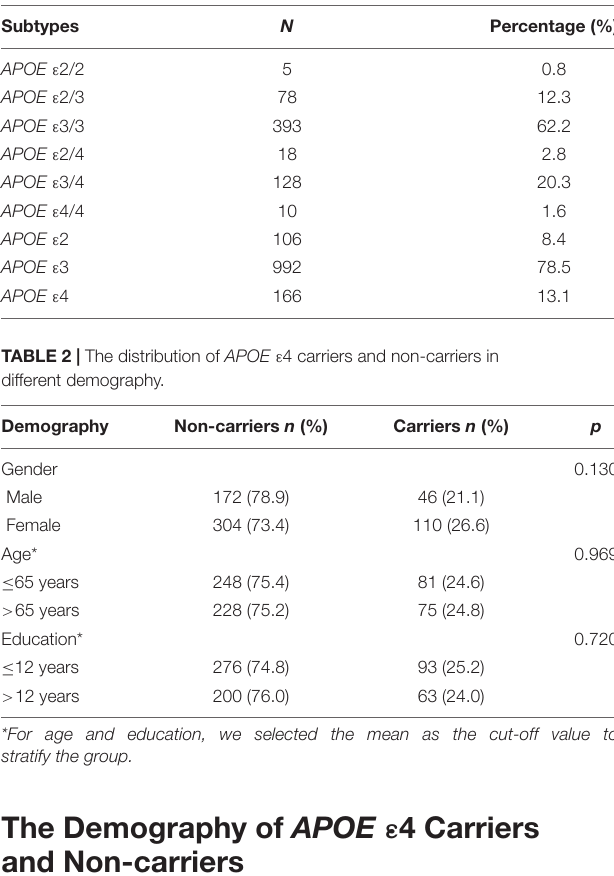
TABLE 1 | The distribution of APOE ε 4 alleles and genotypes in total population.